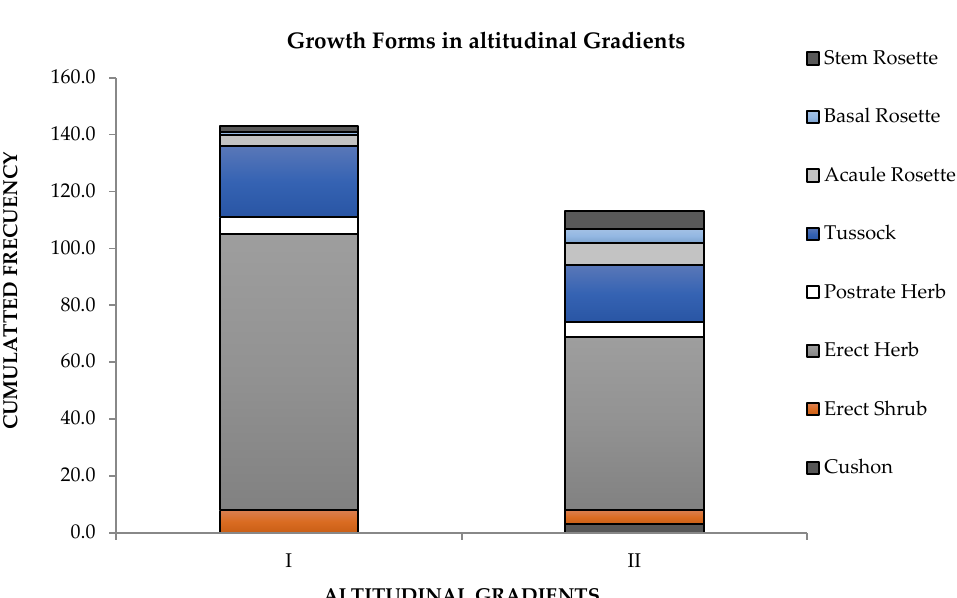
Figure 4. Cumulative frequency values of lifeforms for each community in two altitudinal gradients. Table 2. p -Values of Kruskall–Wallis test, comparing the frequency of lifeforms. * p < 0.05.